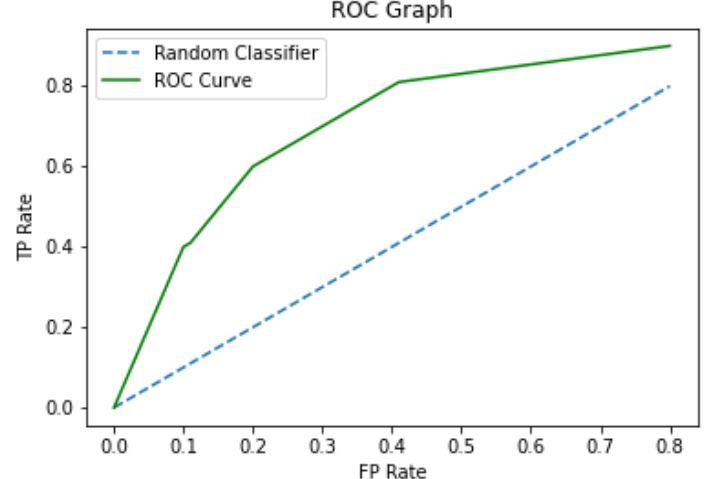
Figure 2. Example of the ROC